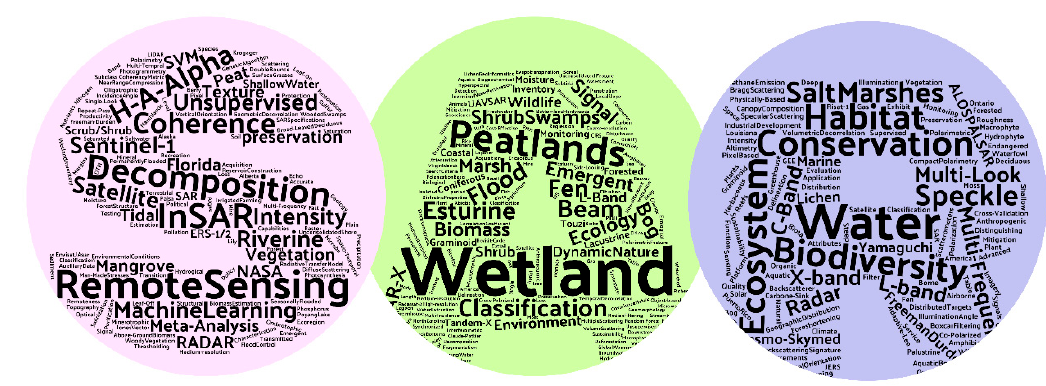
Figure 1. Tag cloud of frequent terms in wetlands monitoring studies using synthetic aperture radar (SAR) data. The size of the text shows the frequency of that specific term.